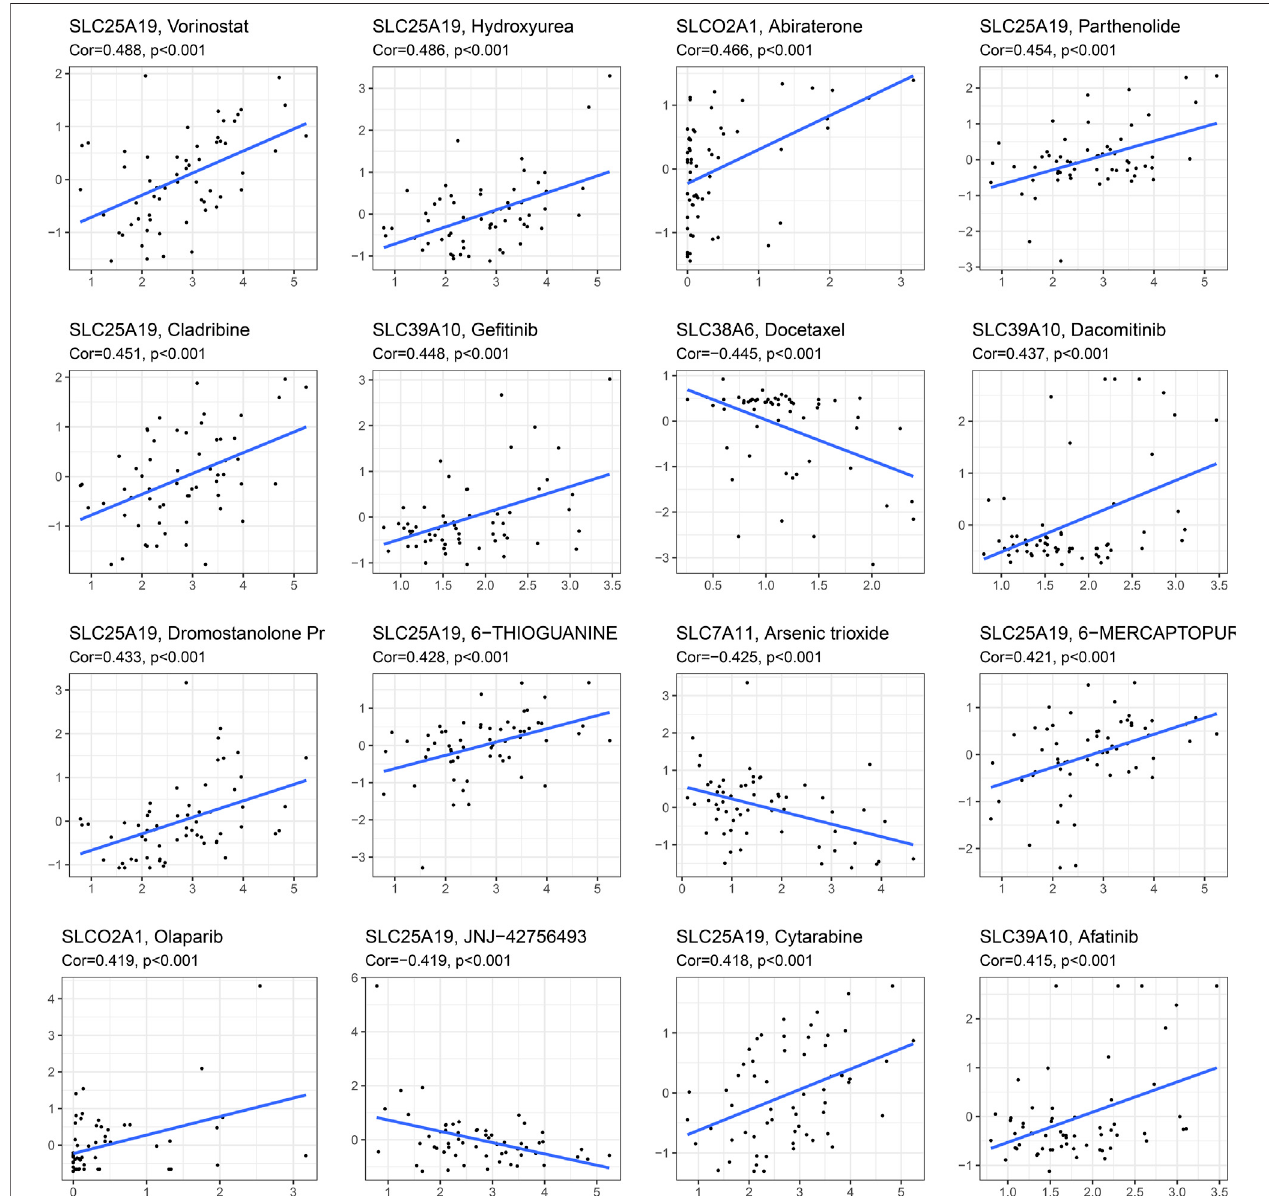
FIGURE 7 | Drug sensitivity analysis. The 16 drugs most correlated with genes in the SLC-related signature ( p < 0.001).